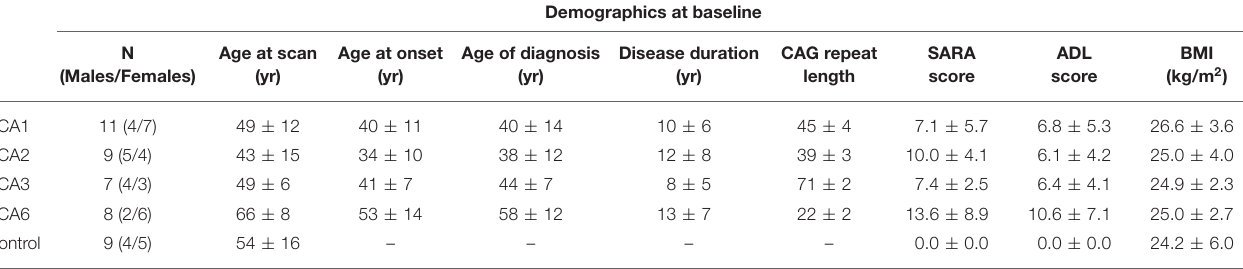
Demographics at